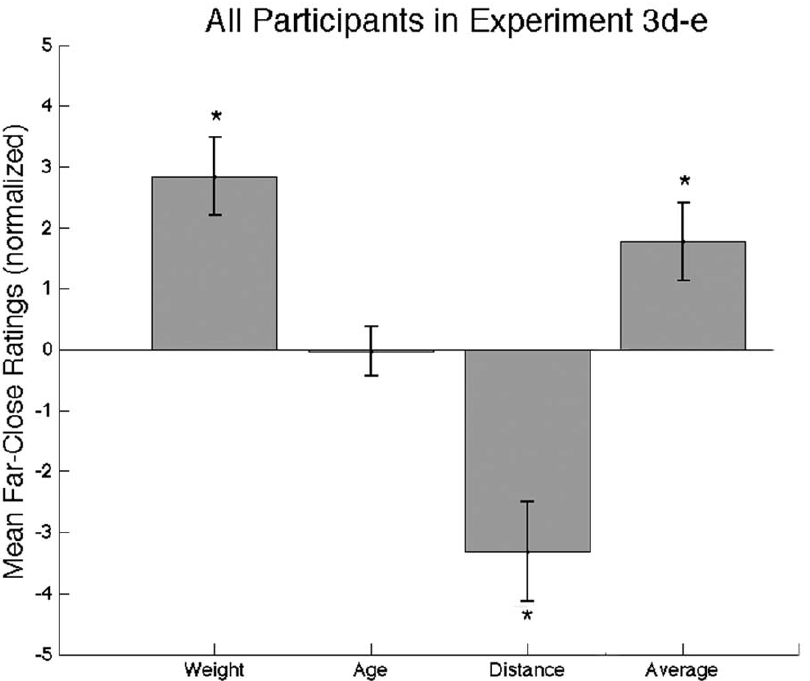
Figure 3. Additional social judgments from perspective distortion (Experiment 3d–e). Shown are means and 95% CI for ratings of Heaviness, Age, Distance to Camera (Experiment 3d), Averageness (Experiment 3e).